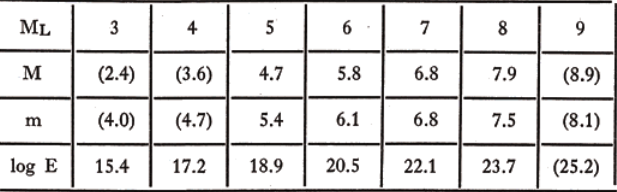
Table 1. Values of M , m and log E for given values of M